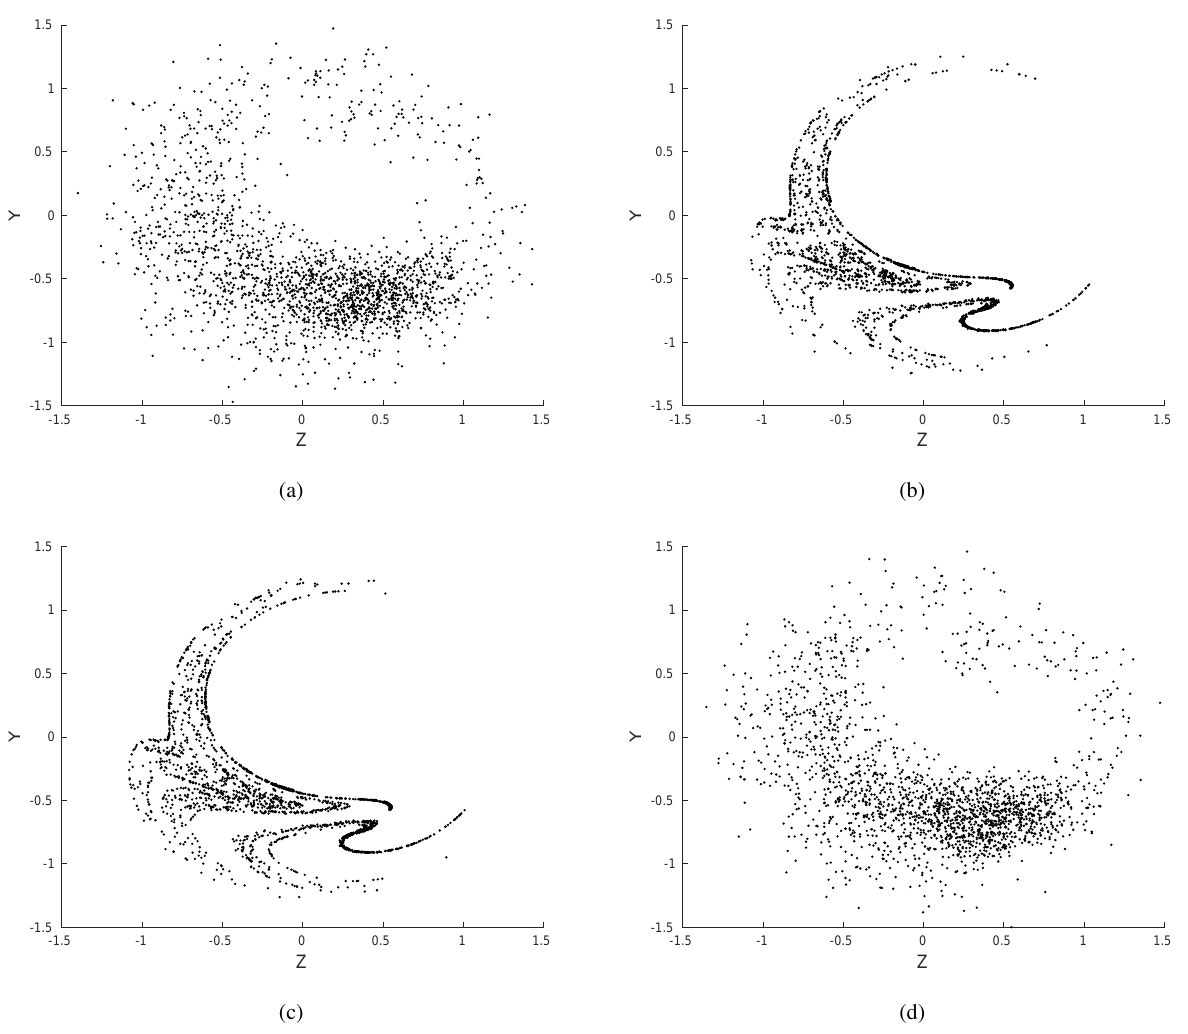
Figure 2. Poincaré section in X = 1 of (a) coupled model, (b) uncoupled model, (c) 1st order parametrization, and (d) 2nd order parametriza- tion. For case τ = 5, the Lorenz 63 model acts as a fast forcing on the Lorenz 84